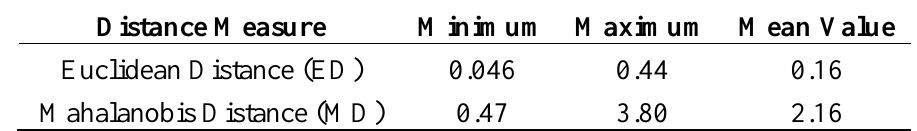
Table 2. Mean, maximum and minimum values for ED and MD under typical operating